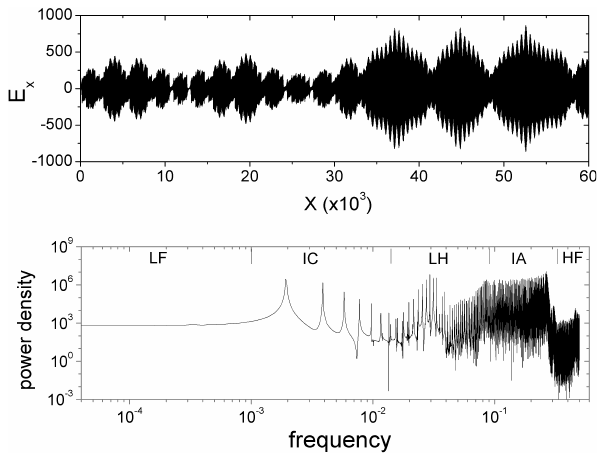
Fig. 18. A preliminary simulation to observed LH oscillitons under U 0 = ( 0 . 2 , 0 , 0 ) , E 0 = ( 0 . 5 , 0 . 5 , 1 ) , and B 0 = ( 0 . 2 , 0 . 5 , 3 ) with M =1, m i /m p =16, T e /T i =10, and v T /c =0.05. See Fig. 1 for a e